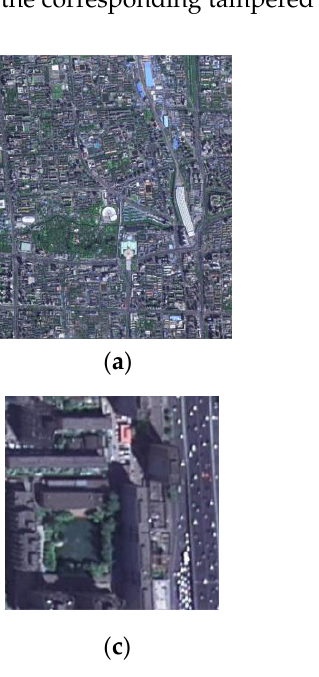
Figure 14. Example of tamper location: ( a ) Original HRRS image, ( b ) Result of Tamper location, ( c ) Original grid cell, ( d ) Tampered grid cell.